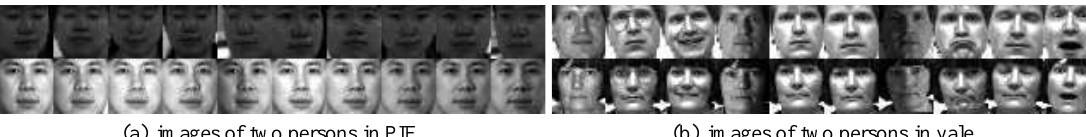
Figure 3: Face images from two databases